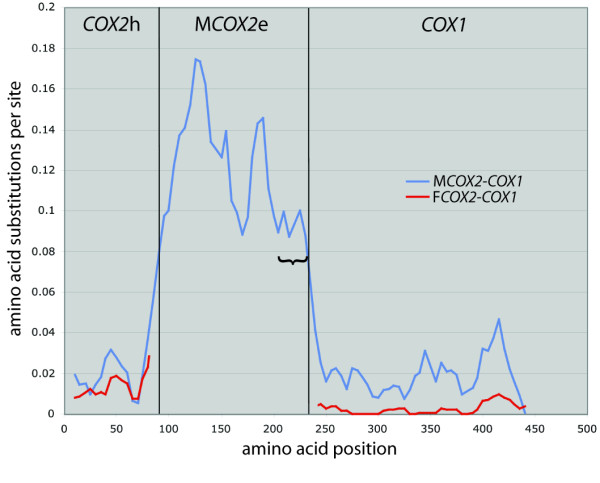
Sliding window plot of amino acid substitutions per site. Sliding window plot of ML-estimated amino acid substitutions per site in the unionoidean bivalve F and MCOX2-COX1 gene junction regions (representing a total of 42 junction regions encoded by 21 F and 21 M genomes and based on a window width of 20 amino acids using five amino acid increments). Regarding the MCOX2 extension region, only the unambiguously alignable (without indels) 143 amino acid positions were utilized in the evaluation of substitution rates. The bracket denotes the C-terminus tail region of MCOX2e.